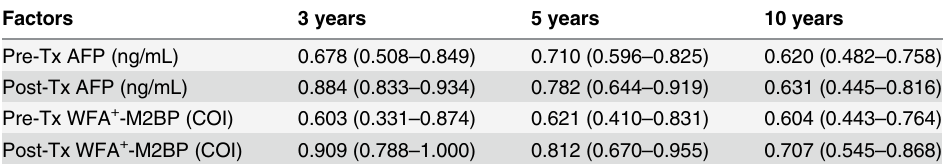
Table 3. Areas under the Curve for Censored Development of HCC at 3, 5, and 10 Years in the WFA + - M2BP and AFP Group.